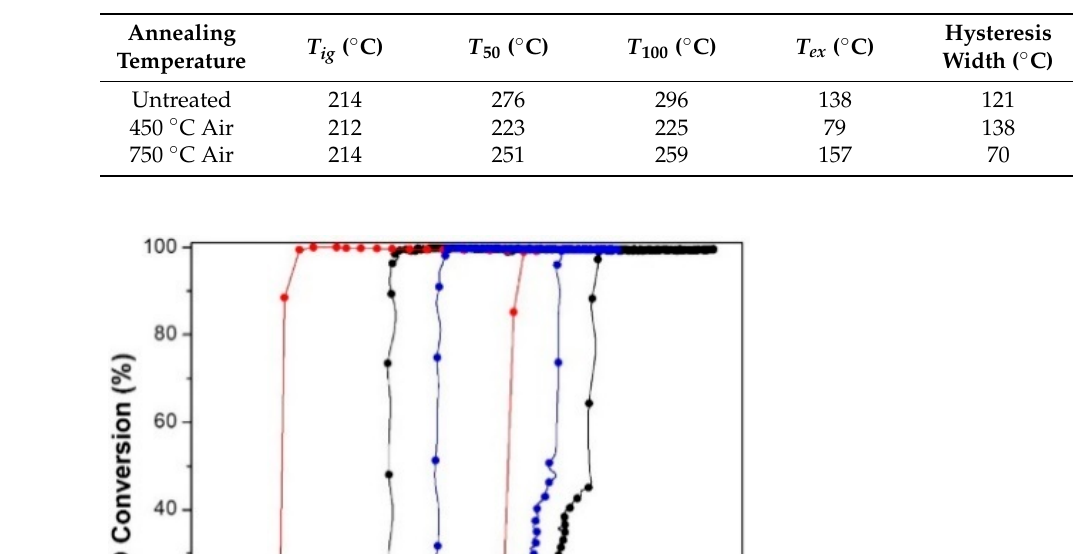
Table 5. Catalytic ignition and extinction profile of Pd/SiO 2 aerogel catalysts annealed in air for 1 h at different temperatures.